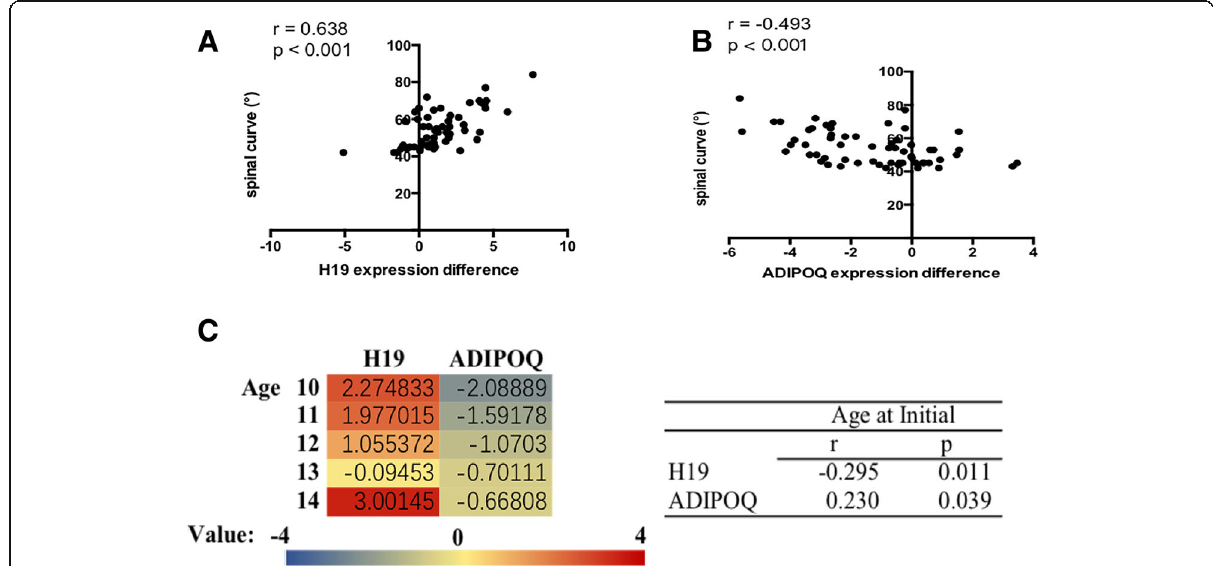
Fig. 4 Expression difference of H19 and ADIPOQ mRNA in paravertebral muscles of AIS patients is associated with curve severity and age at initiation. The relative expression difference of studied genes was calculated as the relative expression level of one gene in concave sided muscle minus that in convex sided. For ( a ), correlation analysis identified that the relative expression difference of H19 in AIS patients ( n = 60) was positively correlated with the magnitude of spinal curve. For ( b ), the relative expression difference of ADIPOQ mRNA in AIS patients ( n = 60) was negatively correlated with the magnitude of spinal curve. For ( c ), Heat map showed significant correlation of the expression difference of H19 and ADIPOQ mRNA in AIS patients ( n = 60) with age at initiation of